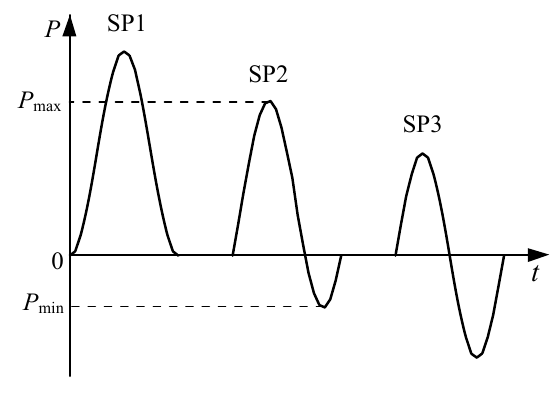
Figure 8. Different cyclic loading types [28].